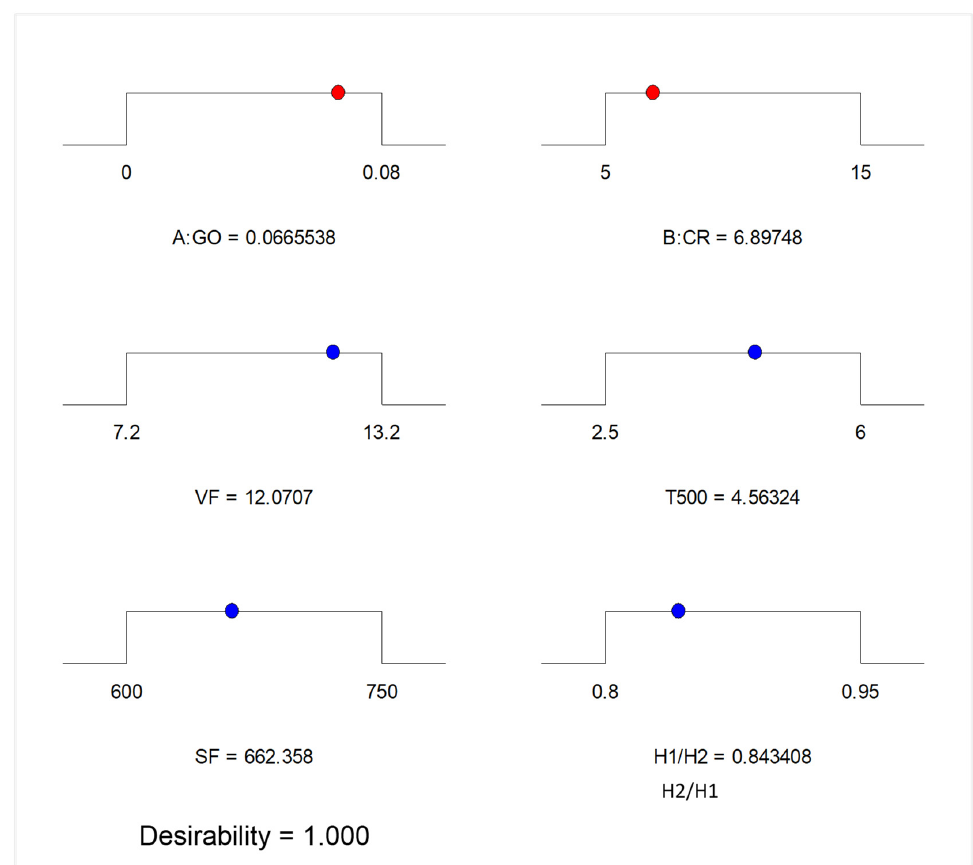
Figure 16. Optimization solution.